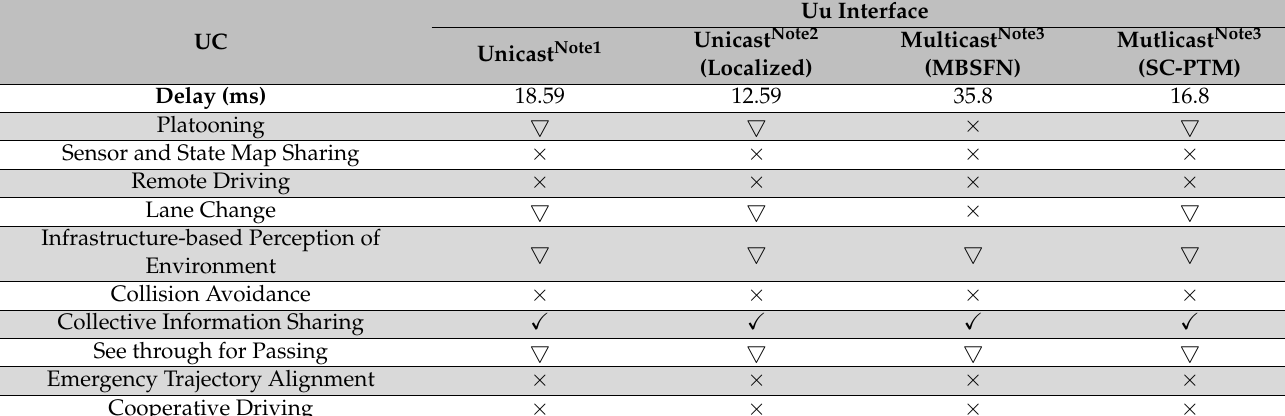
Table 11. 3GPP UC evaluation for